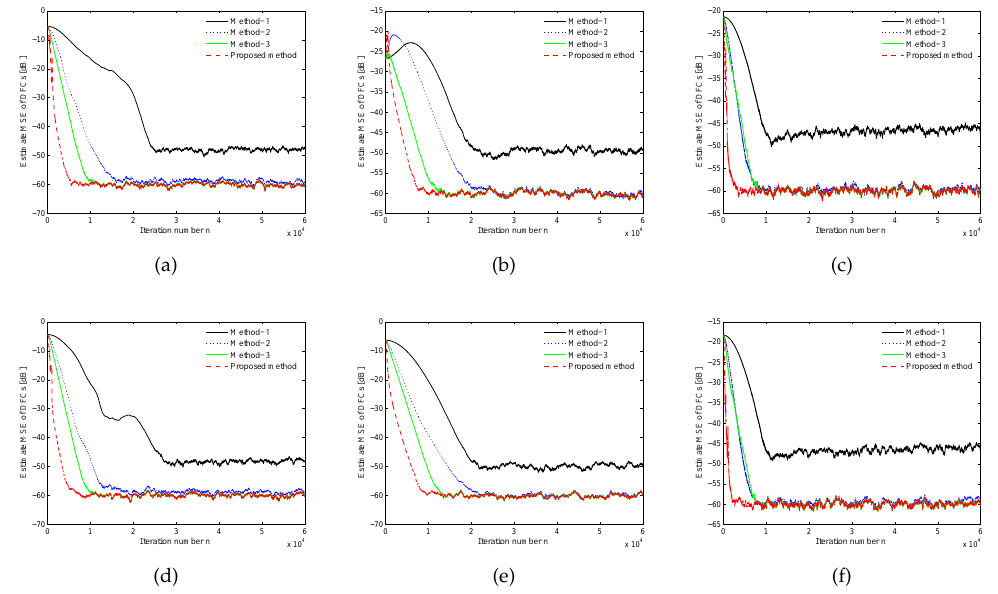
Figure 5. Comparison between the discrete Fourier coefficient (DFC) estimation mean square errors (MSEs) of Method 1, Method 2, and the proposed method for the fixed acoustic path S ( z ) shown in ( n )] ( n )] ; ( f ) E [ ε 2 ( n )] ; ( e ) E [ ε 2 ( n )] ; ( d ) E [ ε 2 ( n )] ; ( c ) E [ ε 2 ( n )] ; ( b ) E [ ε 2 Figure 4a. ( a ) E [ ε 2 a a 3 a 2 b 3 b 2 b 1 1